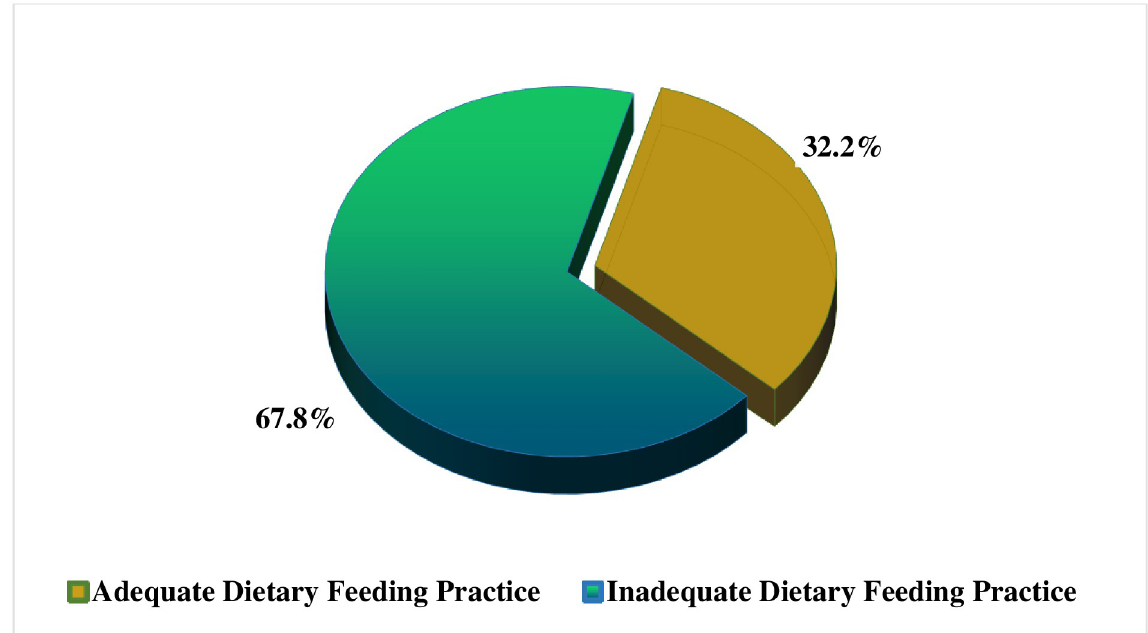
Fig 5. Caregivers’ dietary adequacy feeding practices to their under-five children. Source : Field Data (2022).